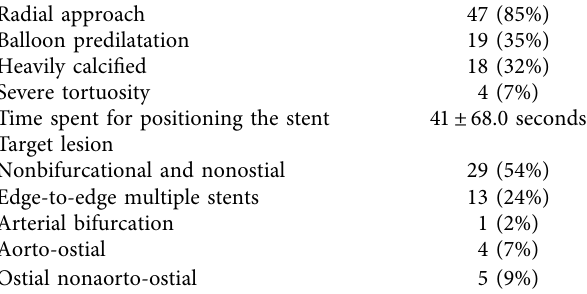
Table 2: Procedural characteristics ( n �